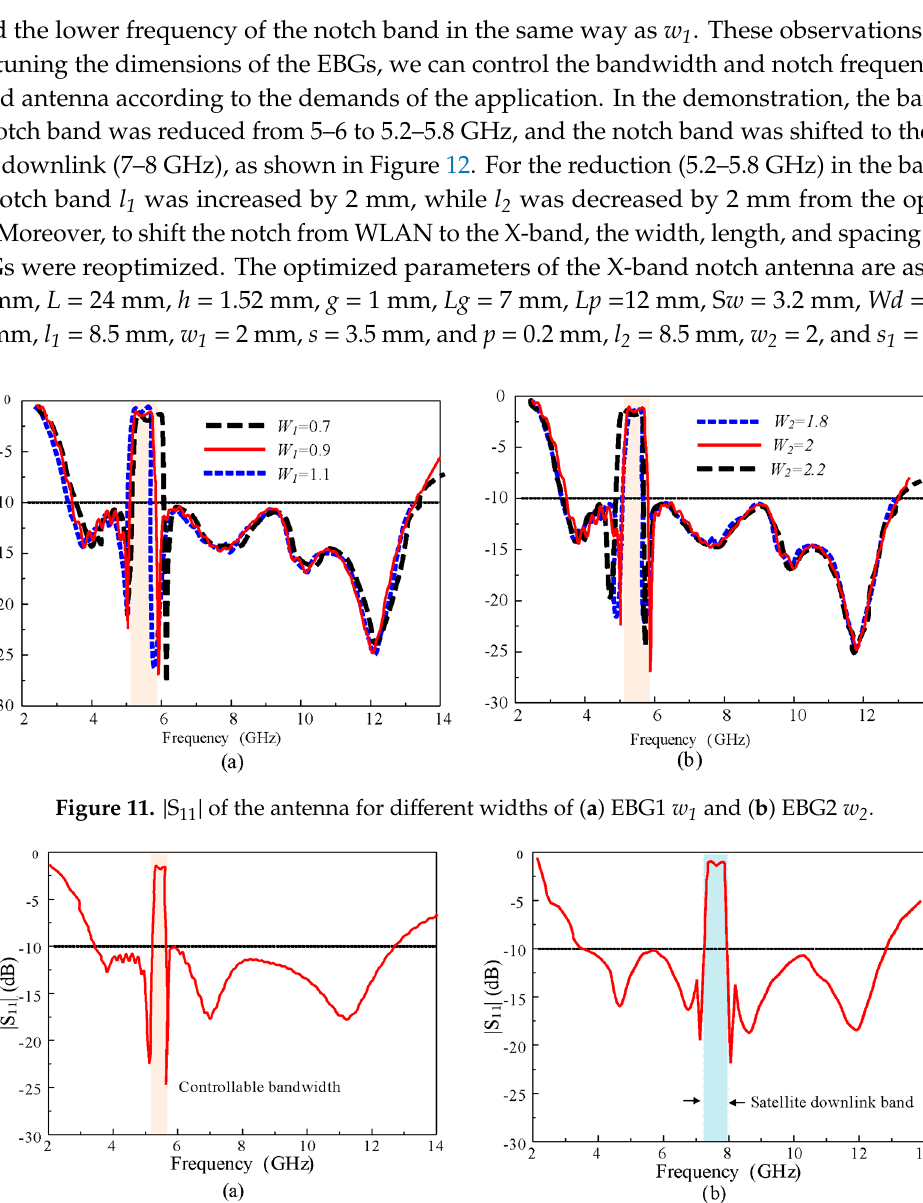
Figure 10. |S 11 | of the antenna for different lengths of: ( a ) EBG1 l 1 , and ( b ) EBG2 l 2 .